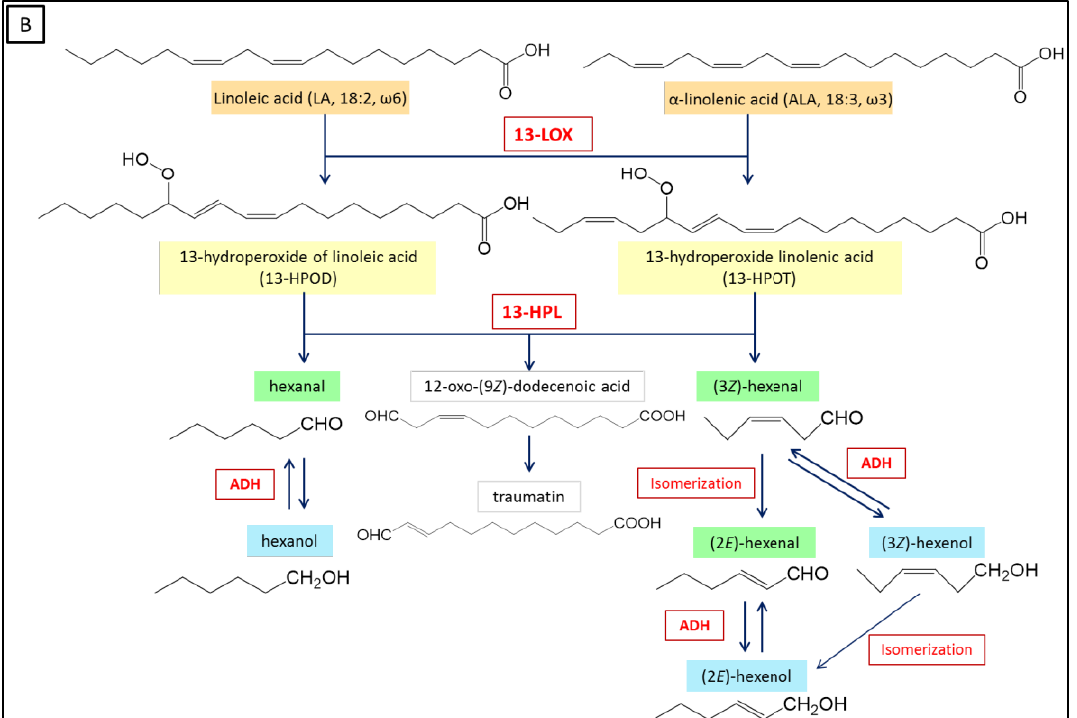
Figure 3. Biosynthesis of green leaf volatile compounds following the LOX pathway. ( A ) 9-LOXs produce 9-hydroperoxy-(10 E ,12 Z )-octadecadienoic acid (9-HPOD) and 9-hydroperoxy-(10 E ,12 Z ,15 Z )-octadecatrienoic acid (9-HPOT). 9-HPLs act on 9-hydroperoxides to form C9 aldehydes and a 9-oxoacid. ( B ) 13-LOXs produce 13-hydroperoxy-(9 Z ,11 E )-octadecadienoic acid (13-HPOD) and 13-HPOT. 13-HPLs act on the 13-hydroperoxides to form C6 aldehydes and a 12-oxoacid. Finally, isomerization, dehydrogenation, and esterification reactions of aldehydes can occur to produce aldehydes with different isomeric forms, alcohols, and esters. Isomerization can occur spontaneously or through the action of an isomerase. The enzymes involved appear in red, the fatty acids are colored in orange, the hydroperoxides are colored in yellow, and the oxoacids are colored gray. The aldehydes and alcohols produced are colored respectively in green and in blue. ADH: Alcohol dehydrogenase.